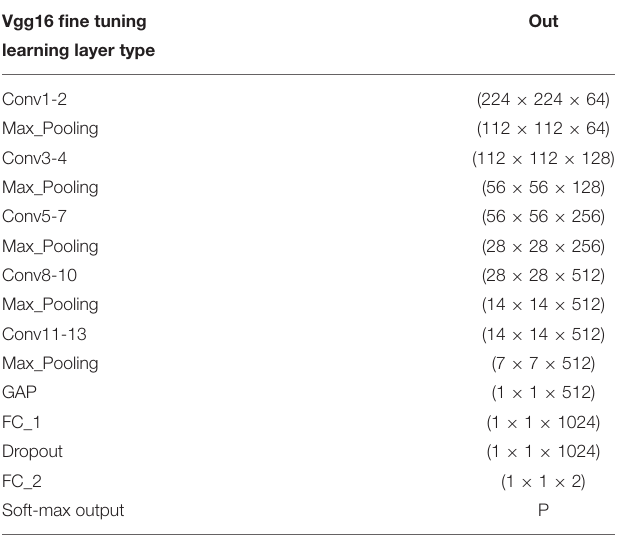
TABLE 1 | CNN network structure parameters.